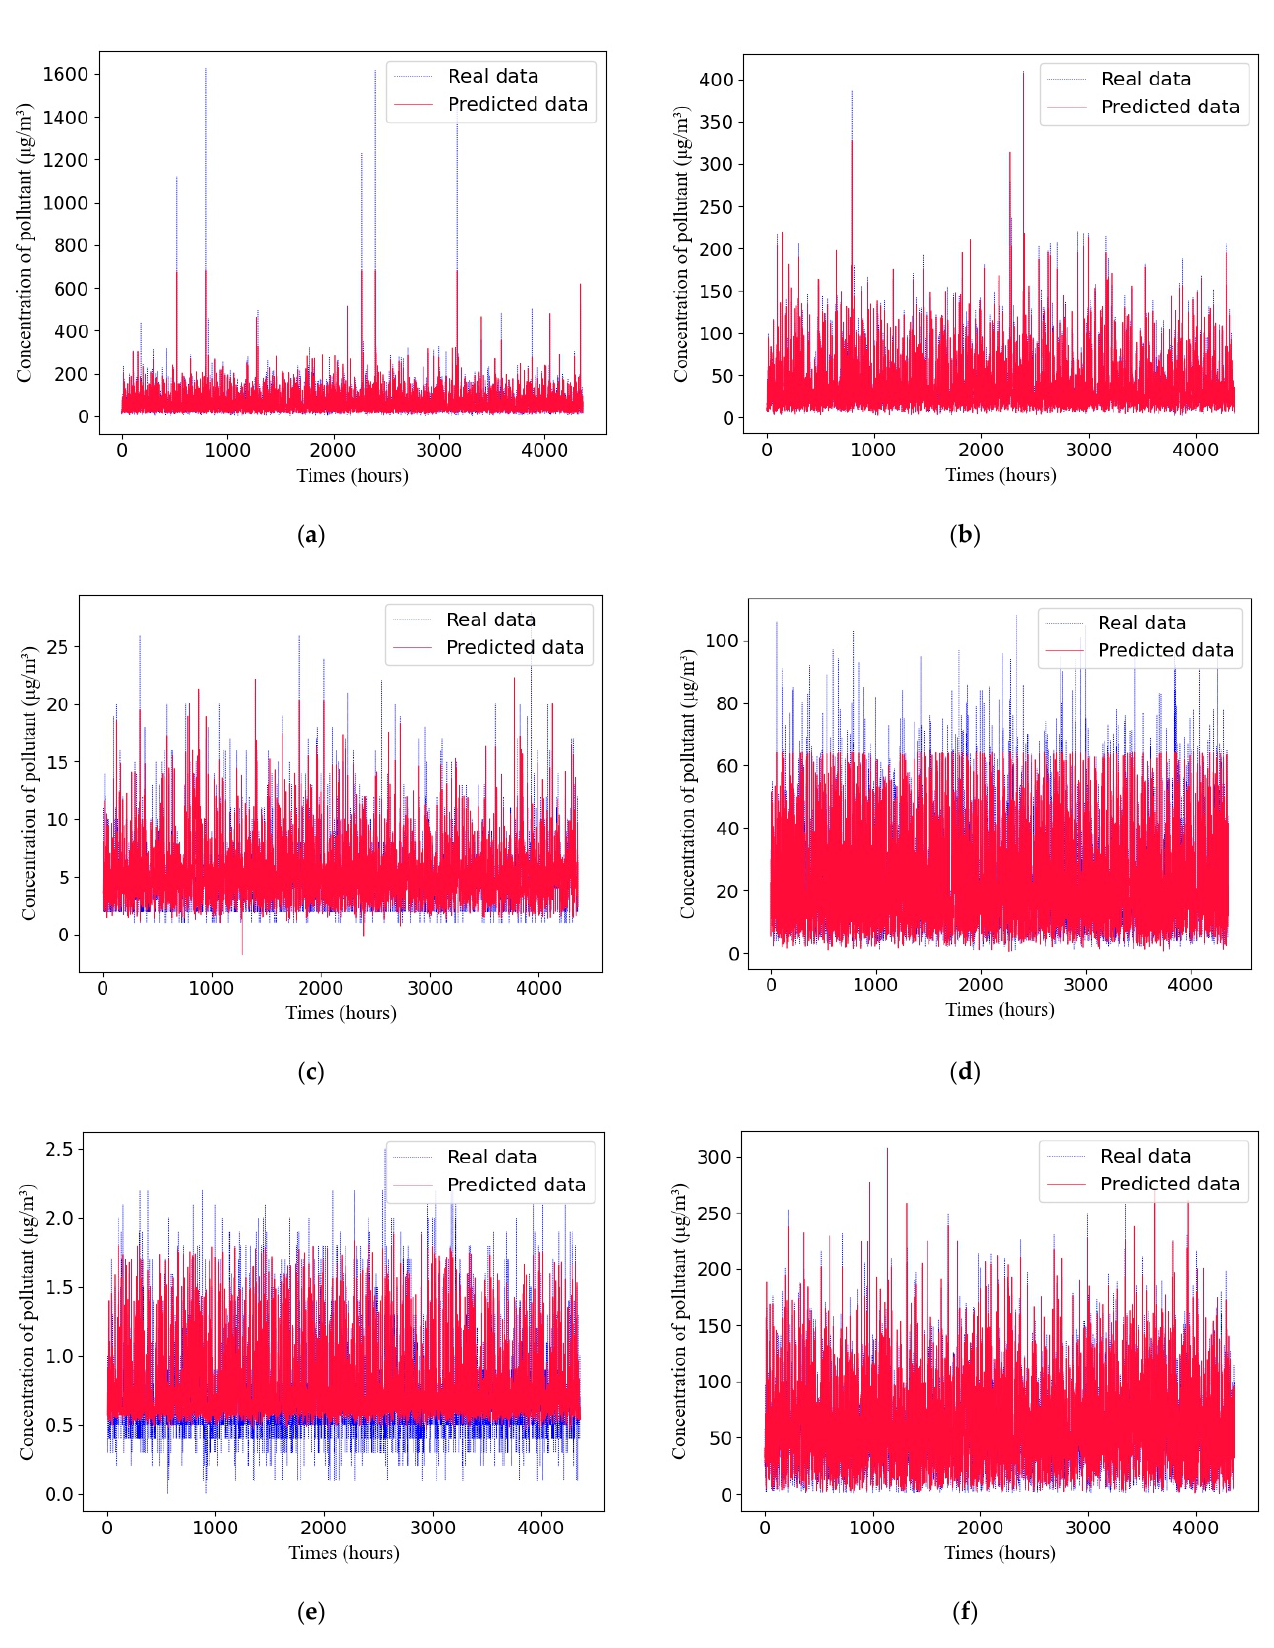
Figure 8. Comparison of predicted values and real values of different pollutants with the GRU network in Dataset 2: ( a ) PM 10 ; ( b ) PM 2.5 ; ( c ) SO 2 ; ( d ) NO 2 ; ( e ) CO; ( f ) O 3 .